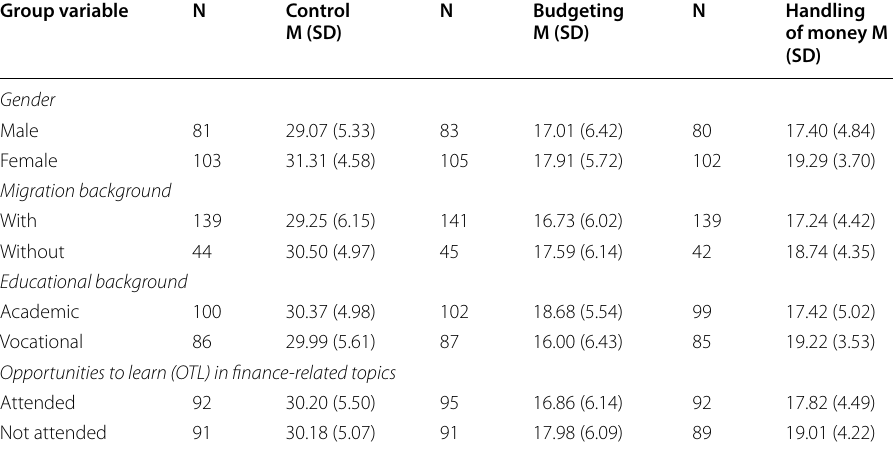
Table 2 Descriptive test results in the three factors of the financial literacy facet, separated by